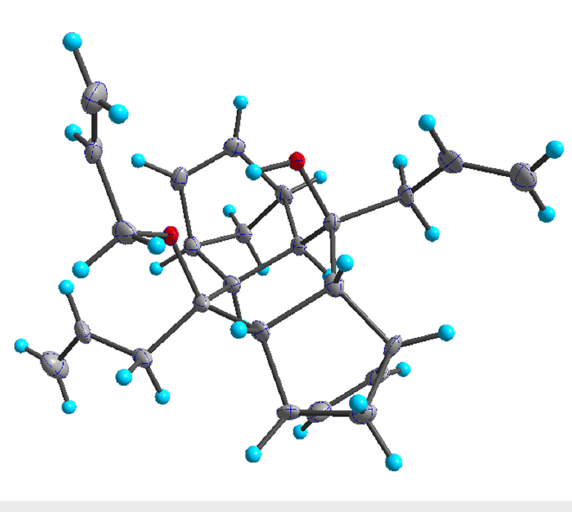
Figure 2: Crystal structure of 5 with thermal ellipsoids drawn at 50% probability